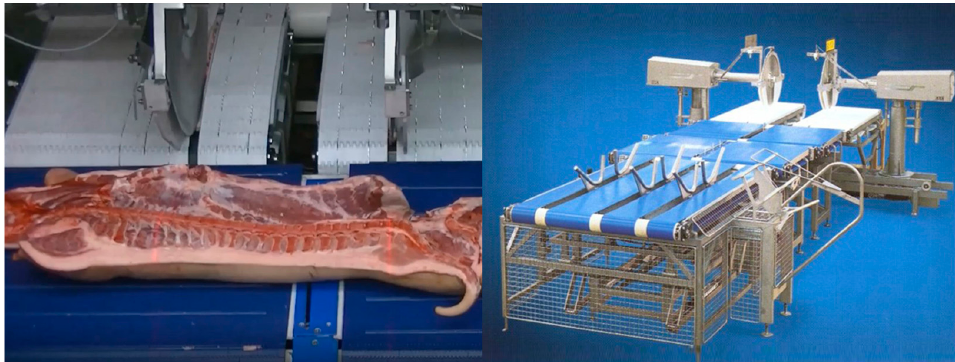
Figure 6. The E + V Technology VCCS 2000 system for the automatic primal cutting of pork carcasses (Reprinted, with permission from Hinz A of E + V technology, Copyright © 2023).